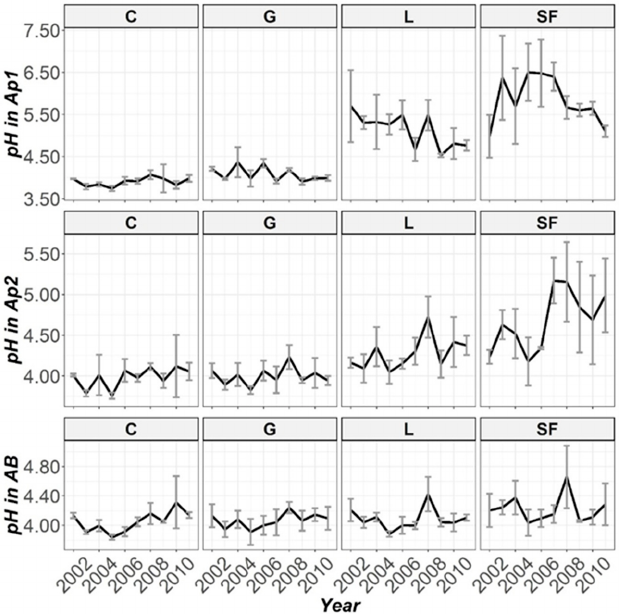
Figure 2. Temporal evolution of pH in the three horizons (Ap1, Ap2 and AB) studied throughout the ten years of soil monitoring (2002–2011).